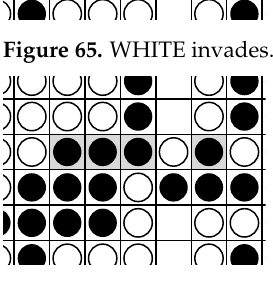
Figure 66. WHITE captures.